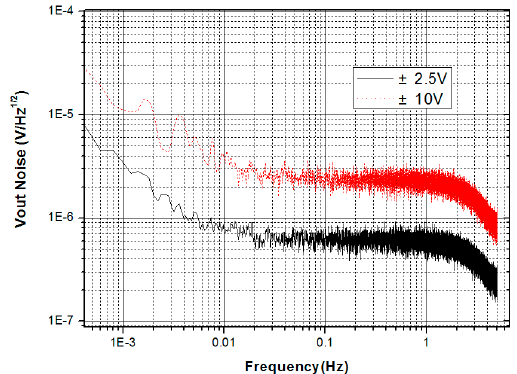
Figure 7. Noise power spectrum density of readout system.